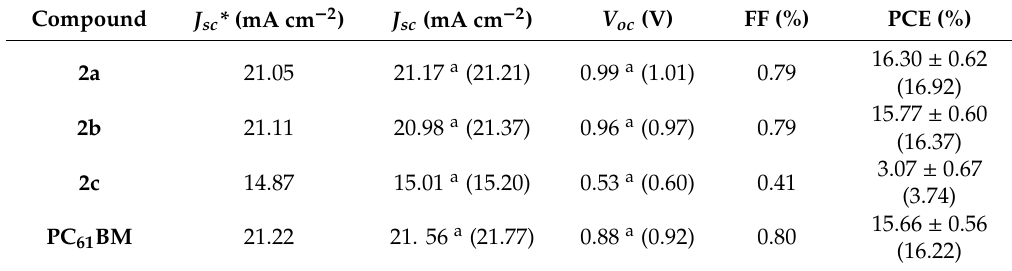
Figure 3. ( a ) Current–voltage ( J-V ) curves under 1 sun of illumination (100 mW / cm 2 ) in forward voltage scans. ( b ) The power conversion e ffi ciency (PCE) histograms measured for 25 independent cells. Table 2. Summary of device performance. The calculated short circuit current ( J sc ) values were obtained from the external quantum e ffi ciency (EQE) curves. Values in parentheses represent the best values measured, a are the average values, and * are the calculated values. PC 61 BM: phenyl-C 61 - butyric-acid methyl-ester.